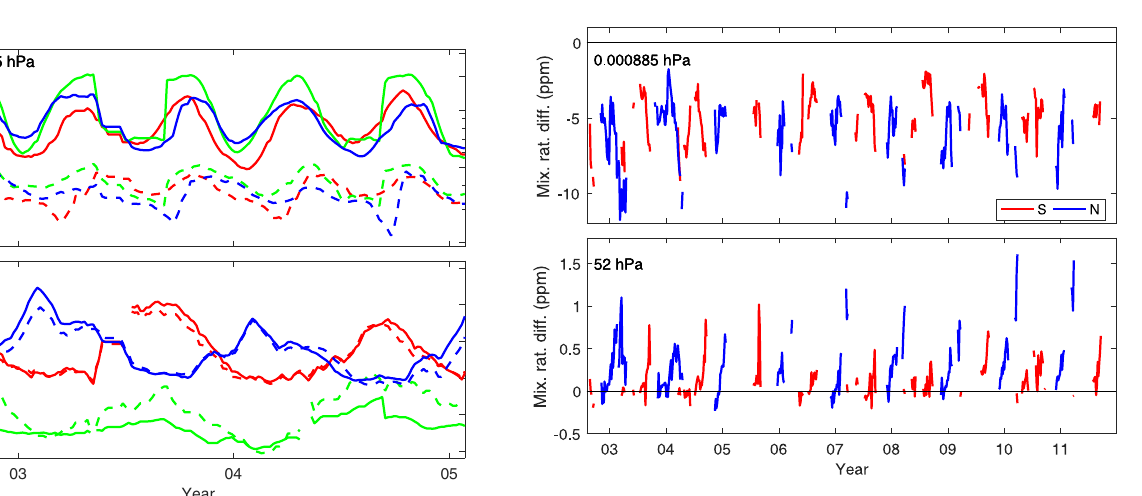
Figure 6. WACCM and GOMOS ozone mixing ratio 5-day time series from 2002 to 2011 in the Arctic 60–90 ◦ N and in the Antarctic 60–90 ◦ S. In the top panel the y axis is logarithmic. The colour coding symbols: W/S and W/N are WACCM in Antarctic, Arctic; G/S and G/N are GOMOS in Antarctic, Arctic.